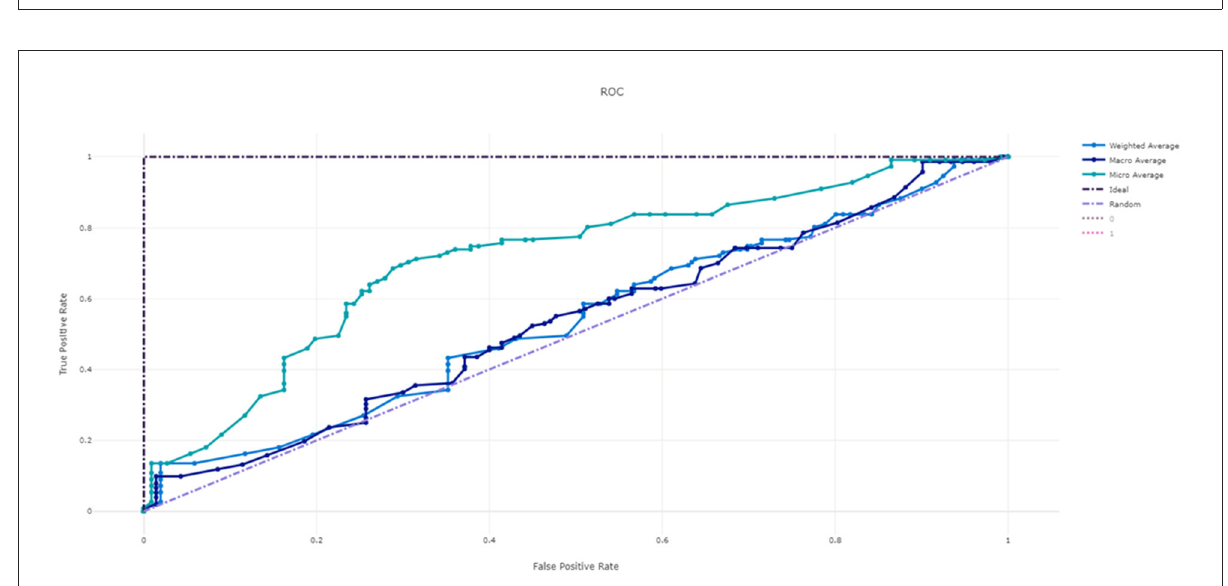
FIGURE4 ROC curve of LightGBM model predicting fall risk among hospitalized elderly.